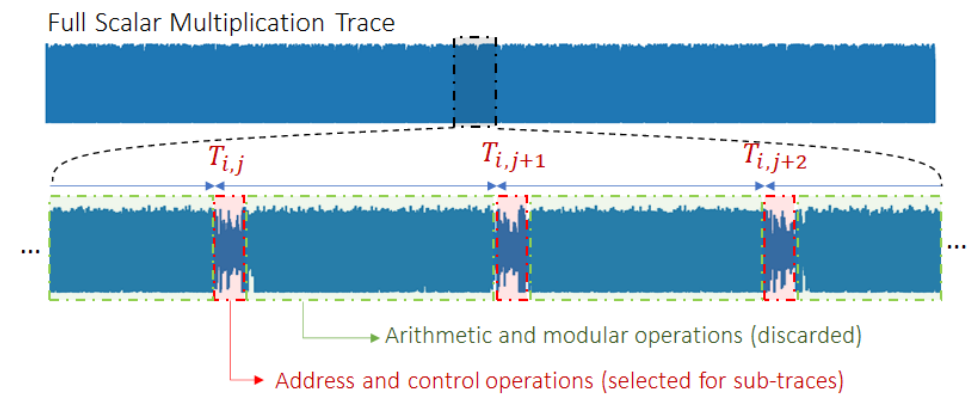
Figure 4: Trace preprocessing for horizontal attacks. The full scalar multiplication traces are split into sub-intervals, each one framing the processing of one scalar bit. The intervals indicated by T i,j (red area) are selected as sub-traces. Green areas are discarded as these parts present no target leakage.